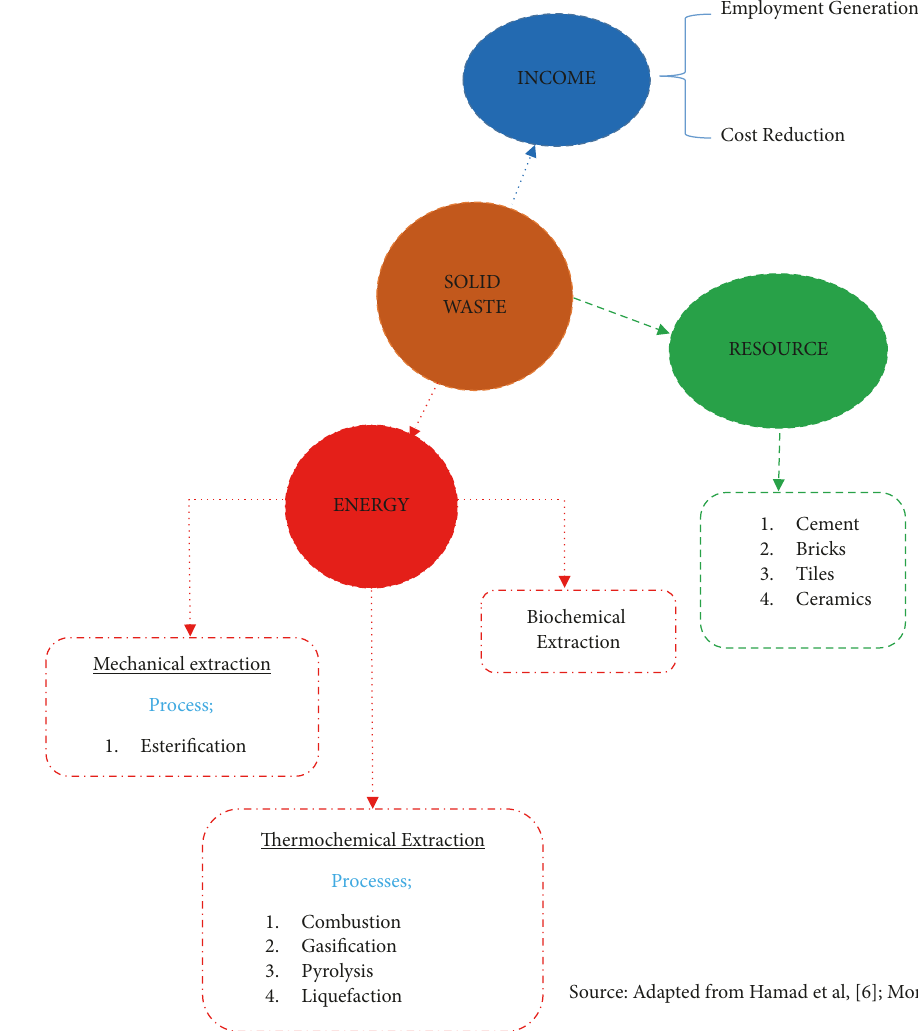
Figure 1: Conceptual framework on the uses and benefits of solid